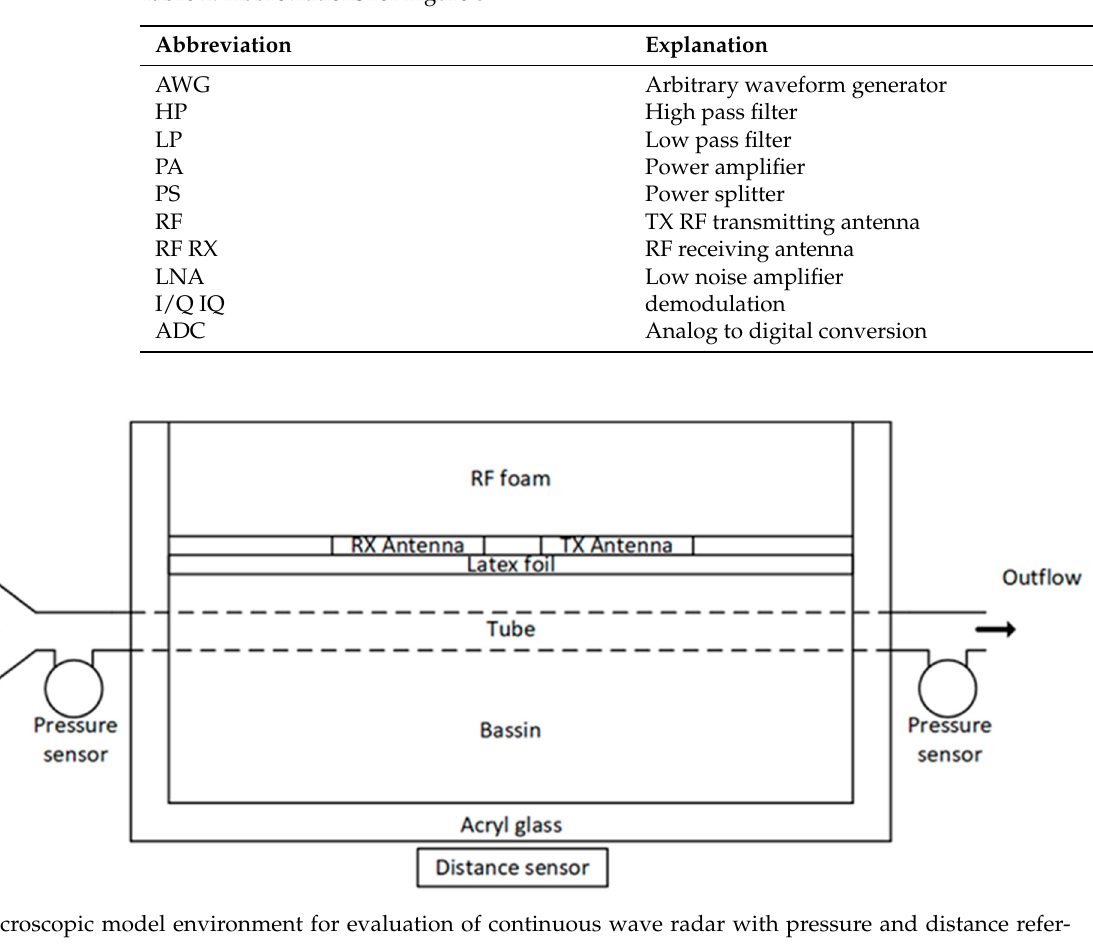
Table 2. Abbreviations for Figure 8.